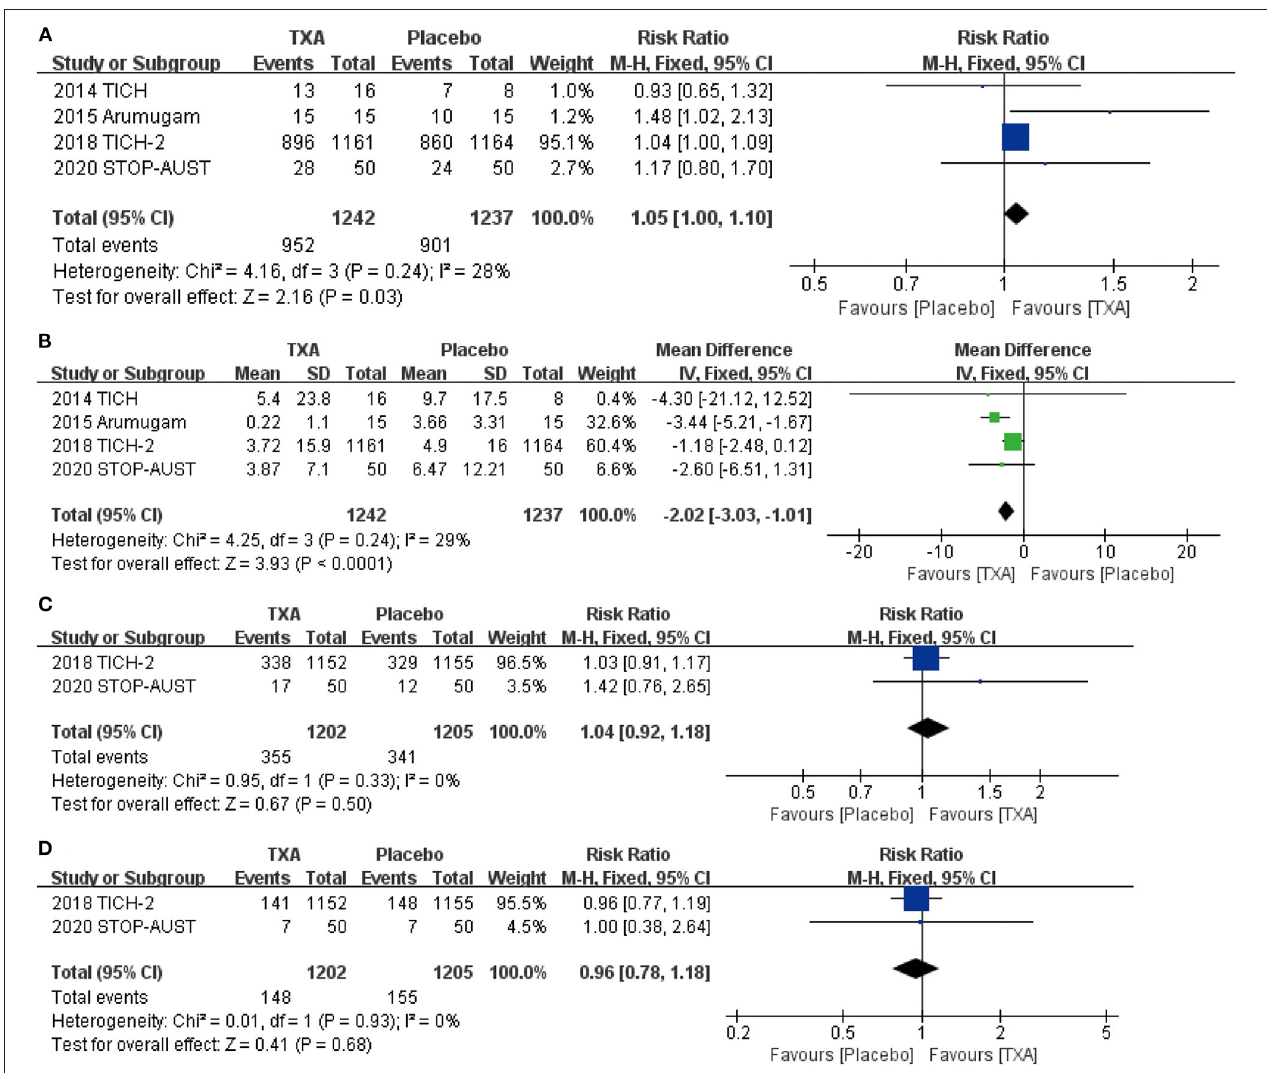
FIGURE 2 | The pooled risk ratio (RR) and mean difference (MD) compared with placebo, the diamond indicates the estimated RR with 95% confidence interval (CI) for the pooled patients. (A) no hematoma expansion (the number of hematoma expansion subtract from total); (B) change in hematoma volume from baseline; (C) mRS (modified Rankin Scale) 0–1; (D) mRS (modified Rankin Scale)